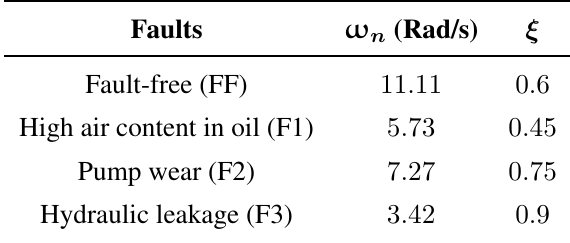
Table 2. Parameters for the hydraulic pitch system under different conditions